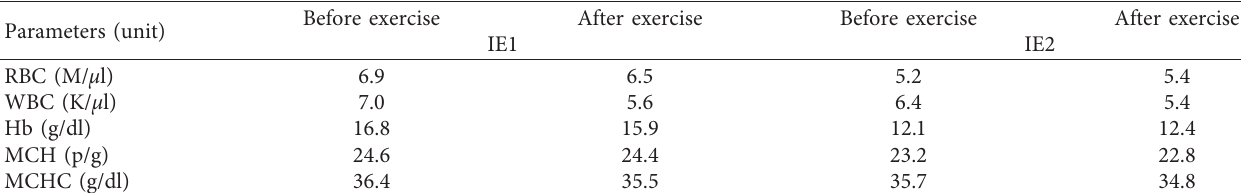
Table 6: Changes in hematological parameters after interval exercise in dogs.